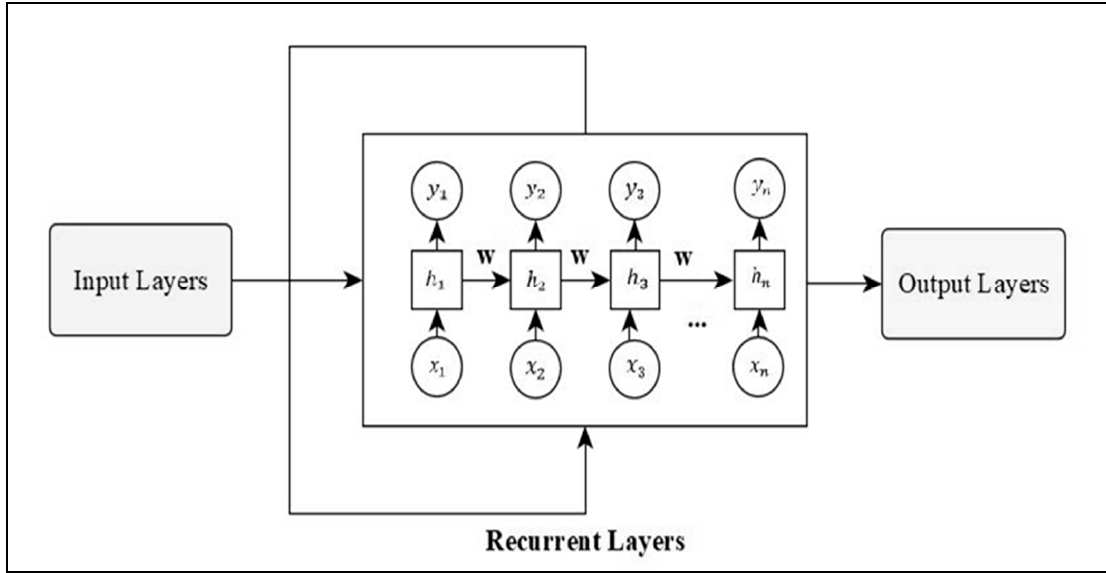
Figure 2. Architecture of RNN. Figure 2.